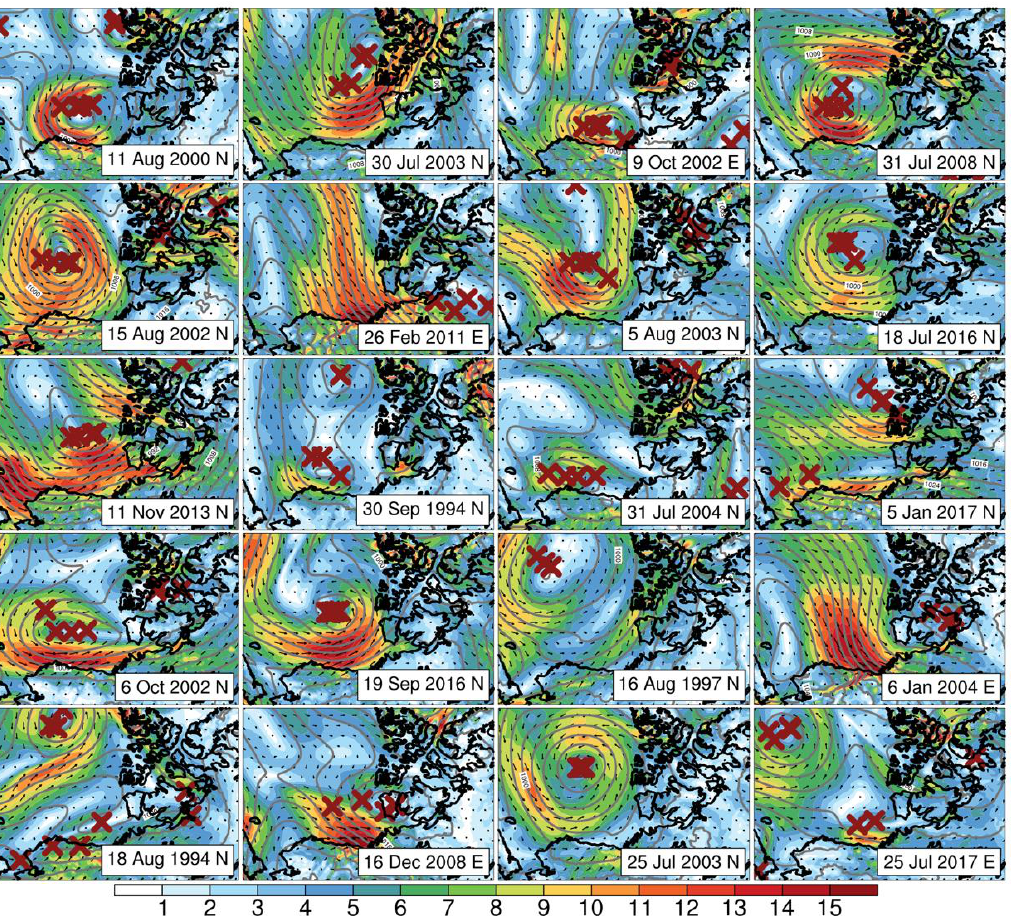
Figure 6. Sea level pressures (gray contour lines), wind speeds (m/s, shading), wind vectors, and the locations of storm centers (red X) for the days with extreme high water levels listed in Table 1. The 25 July 2017 event is not shown as it was outside of the available date range of the downscaled ERA-Interim. The map classification (N — north; E — east) is shown along with the date in the label on each panel.